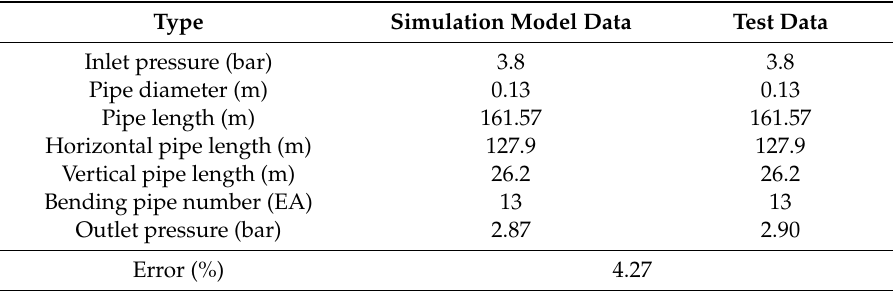
Figure 9. Comparison of simulation and experimental results. Table 5. Comparison of simulation and experimental results